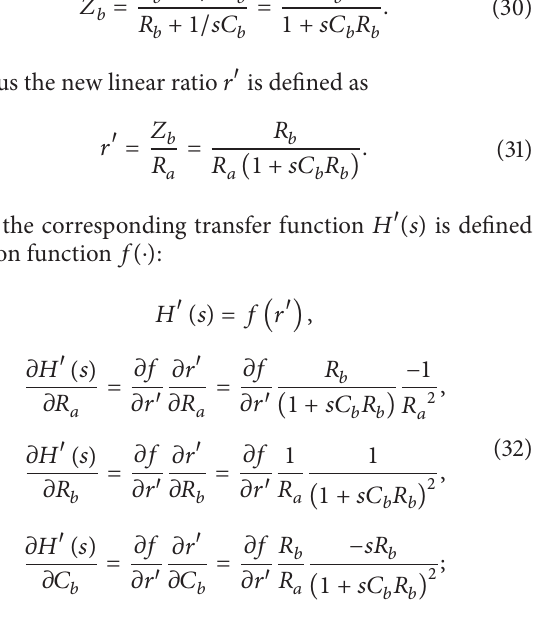
Figure 6: Flowchart of bypassing-based DFT and